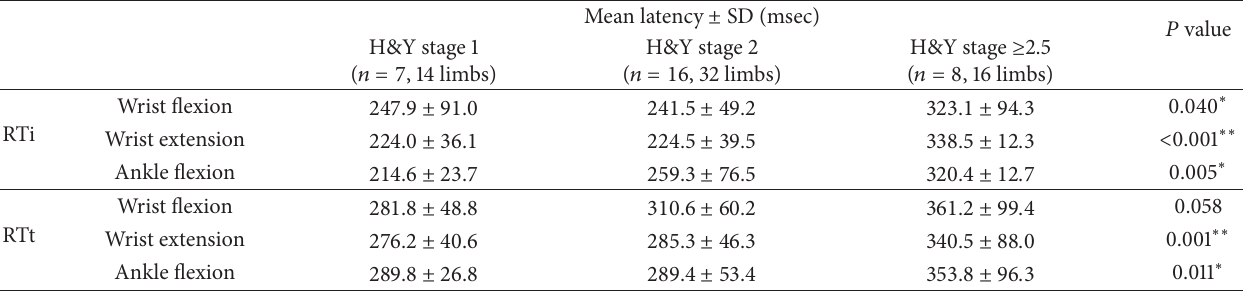
Table 3: Comparison of RT values between the three Parkinson’s disease groups classified according to Hoehn and Yahr